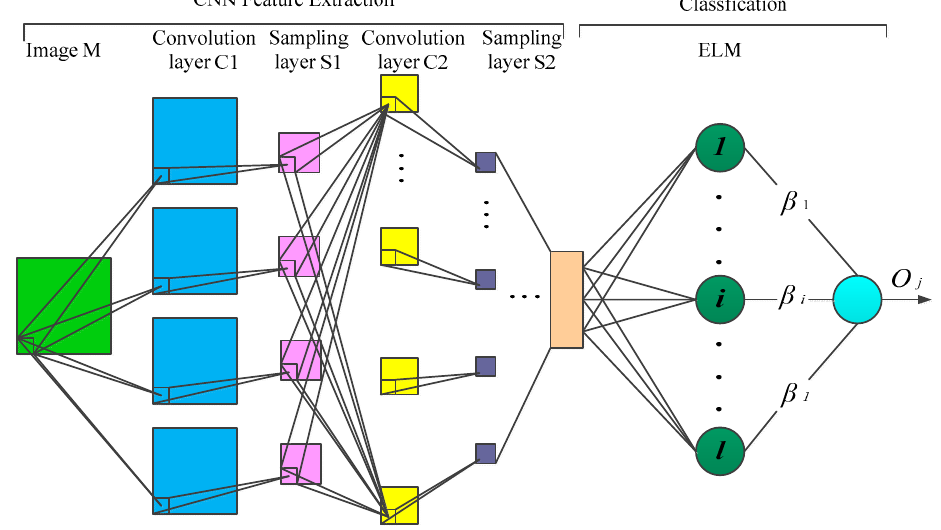
Figure 5. Contrast diagram of optimized CNN feature extraction effects.